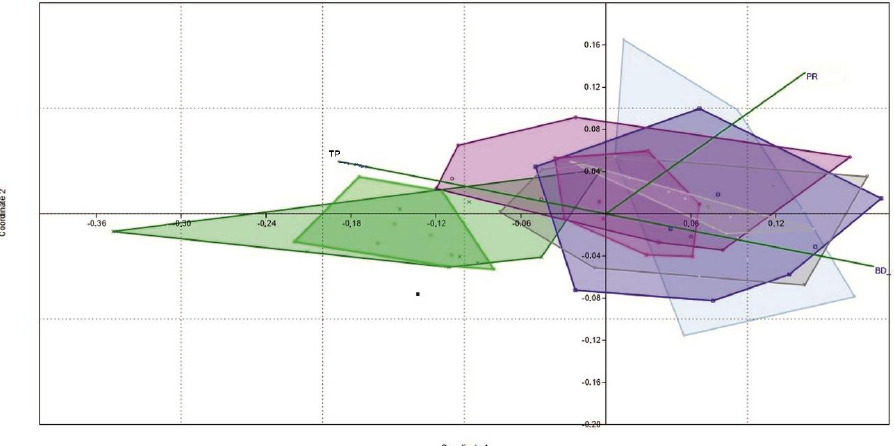
Figure 3. nMDS analysis for the soil situation 20 years after forest harvesting, related to the possible impact, for the main variables (classes of light colors: slope < 20%; classes of dark colors: slope > 20%; green: control; violet: low intensity traffic; grey: medium intensity traffic; blue: high intensity traffic).